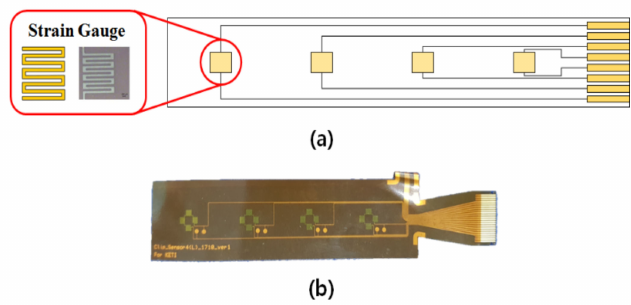
Figure 1. FlexibleEpidermalTactileSensorArray(FETSA).( a )DesignoftheFETSA.( b )Fabricatedsensor.